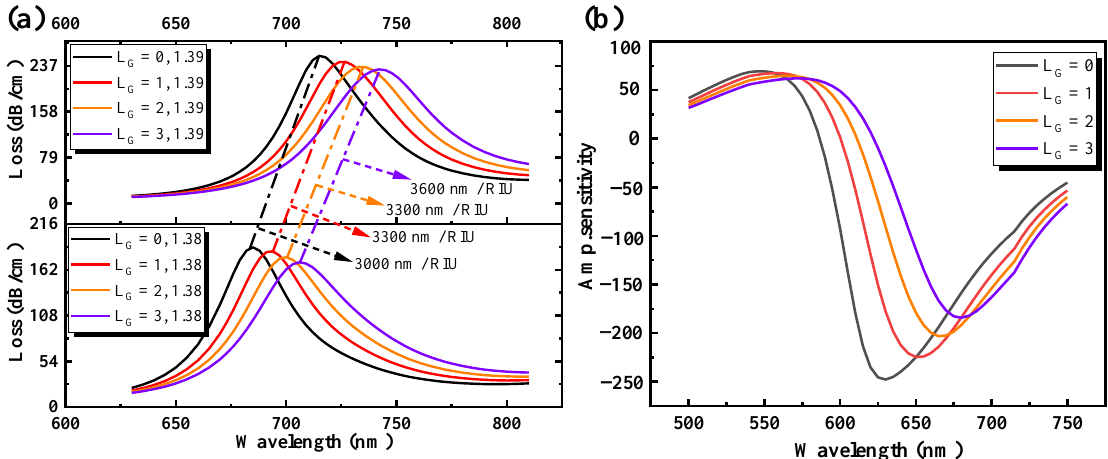
Figure 6. ( a ) Loss spectrum curve. ( b ) Amplitude sensitivity curve with different graphene layers from L G = 0 to 3.